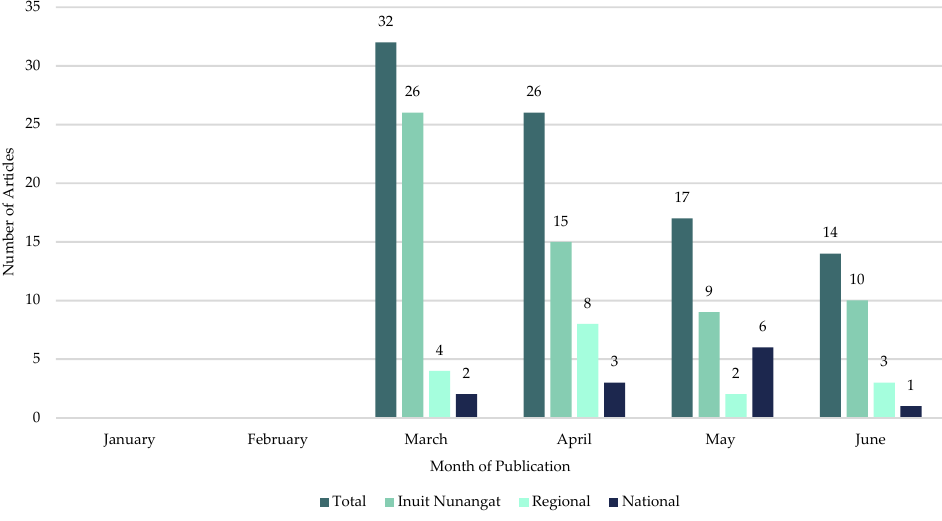
(n = 6 articles each) of the total included articles. Figure 4. Number of articles, by publisher and region, of included articles on the mining industry’s initial response to COVID-19 in Inuit Nunangat from 1 January 2020, to 30 June 2020.